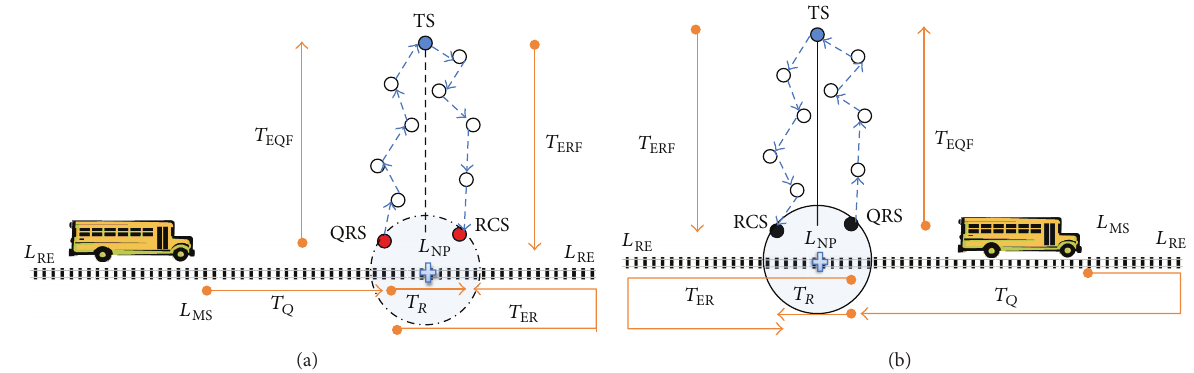
Figure 3: Least Energy Consuming Schedule when MS moves in the direction of TS (a) and when it moves in the other direction (b).